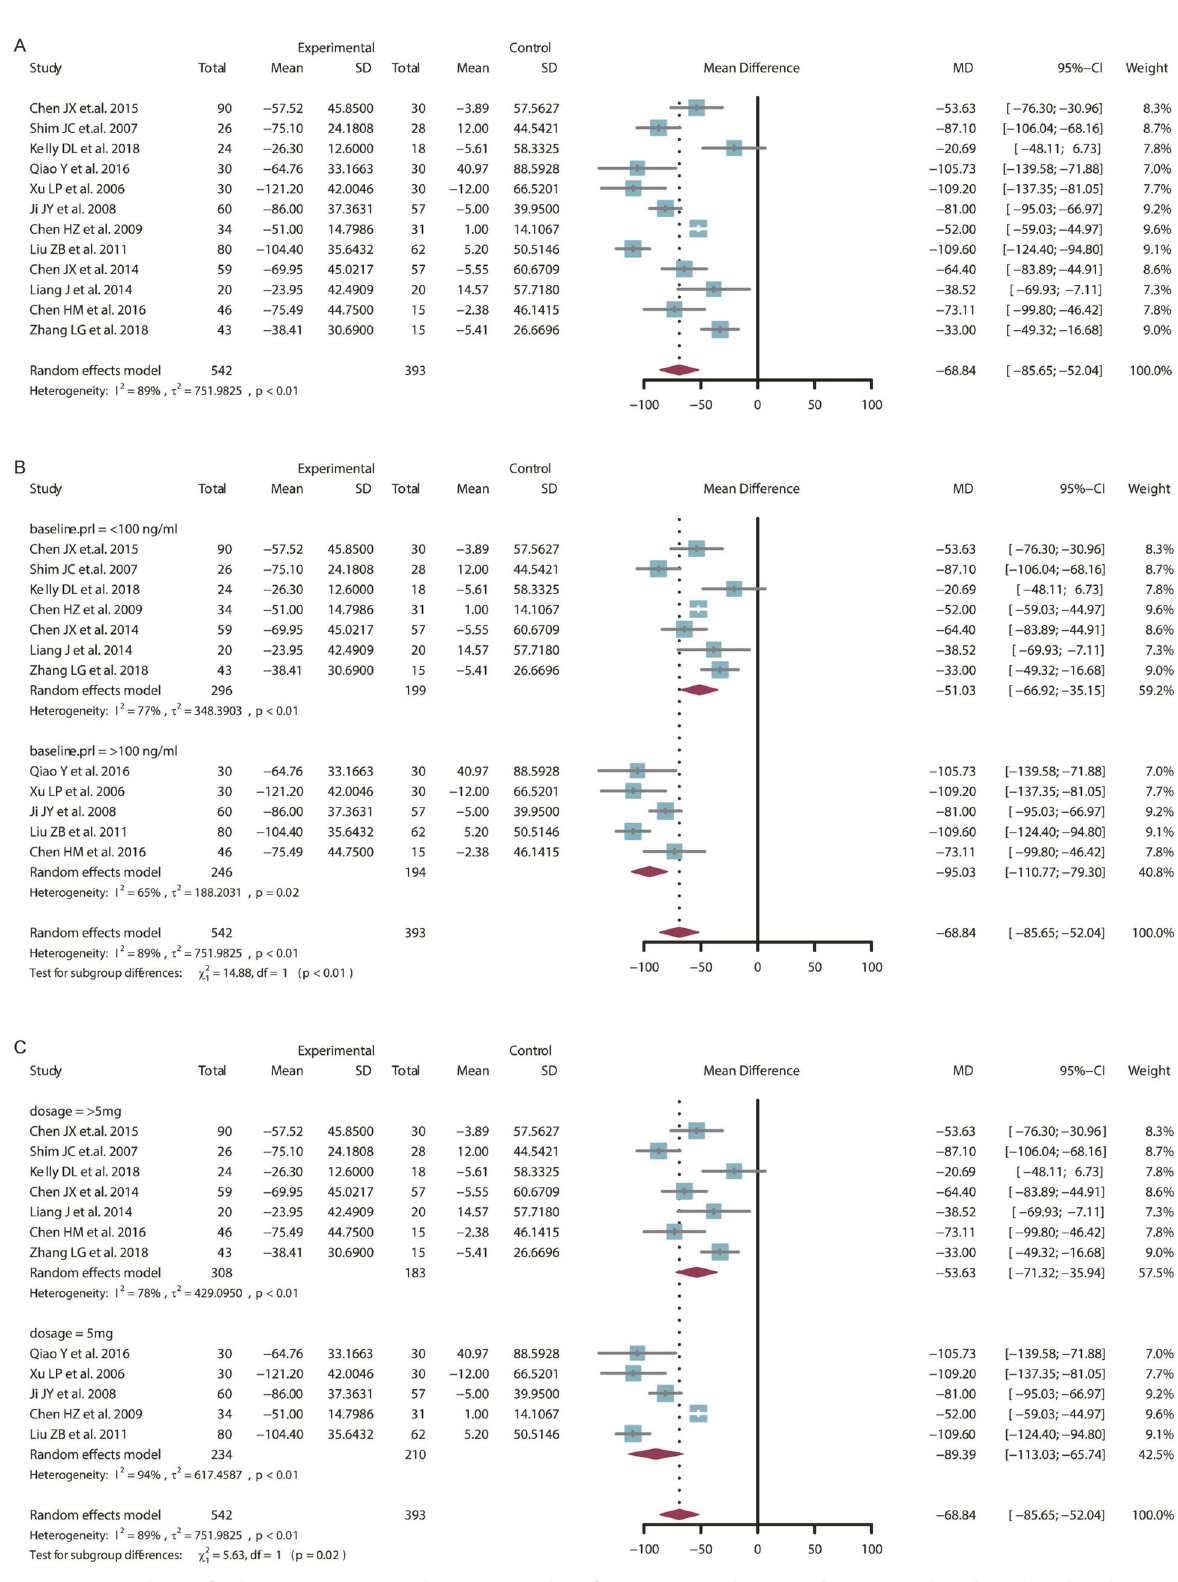
Fig. 2 RCT meta-analysis of adjunctive aripiprazole. A Forest plot of RCT meta-analysis; B subgroup analysis based on baseline PRL level; C subgroup analysis based on ARI dosage. RCT randomized controlled trials, PRL prolactin, ARI aripiprazole, MD mean difference, CI con fi dence intervals, SD standard